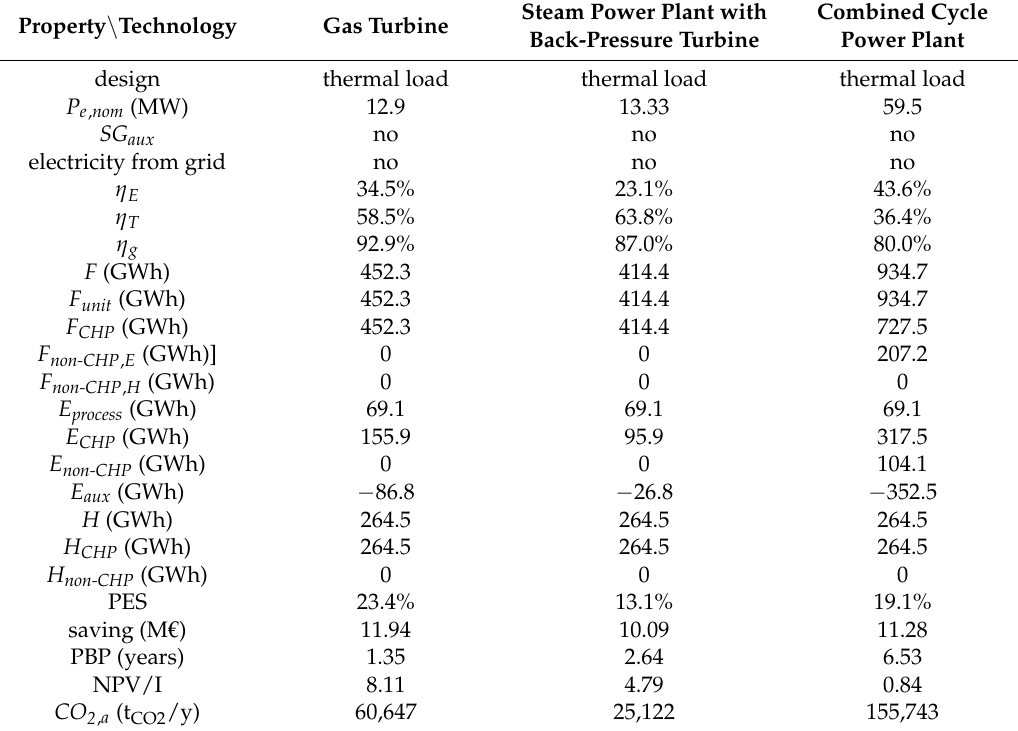
Steam Power Plant